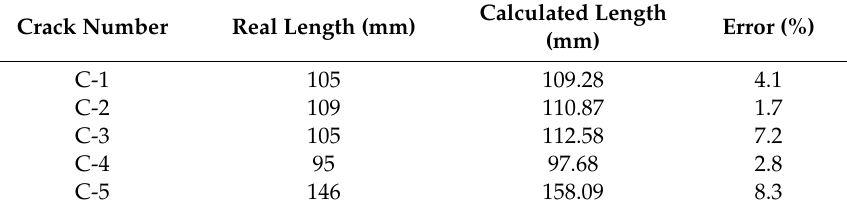
Table 3. Crack length and